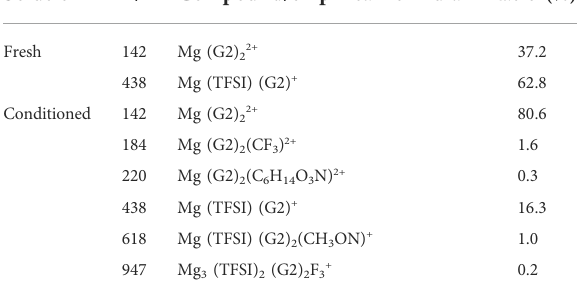
TABLE 2 Mass spectra speciation of the major cation species probed by ESI-MS for freshly prepared and conditioned 0.5 M Mg (TFSI) 2 / G2 solutions.